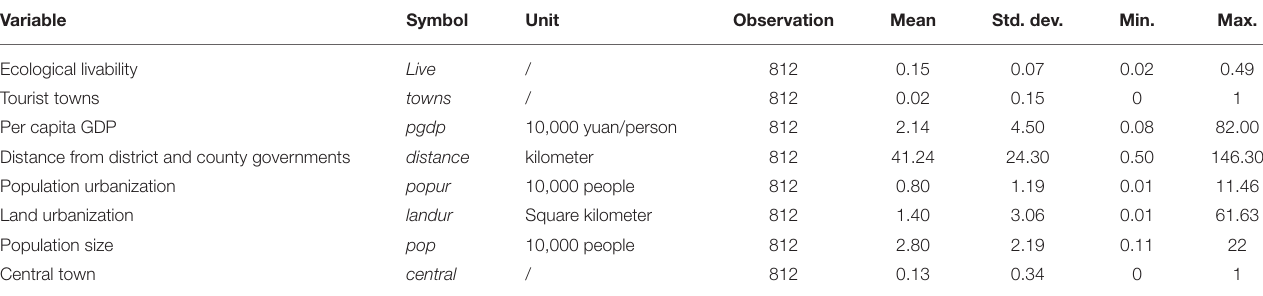
TABLE 3 | Descriptive statistics.